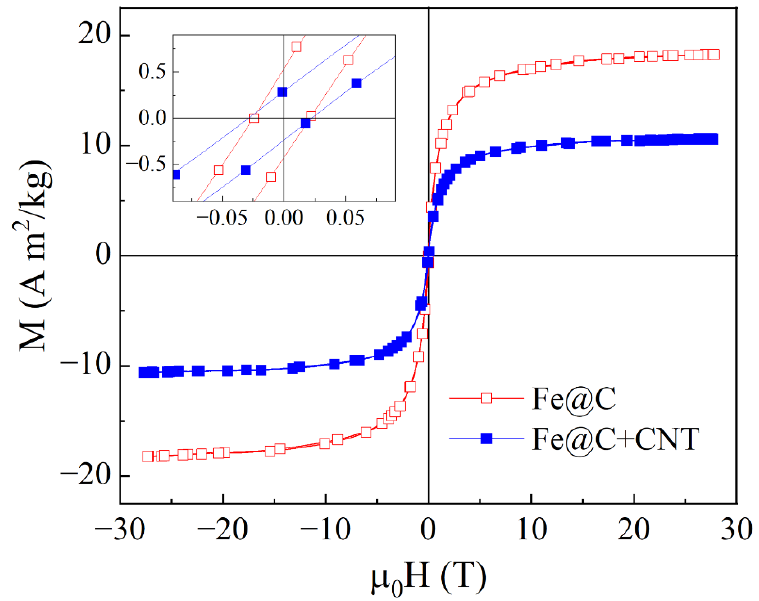
Figure 5. Magnetization curves for the composites containing Fe@C particles and Fe@C + CNT, measured at the room temperature. Inset shows the parts of the hysteresis loops. Here and further µ 0 = 4 π × 10 − 7 H/m is the magnetic